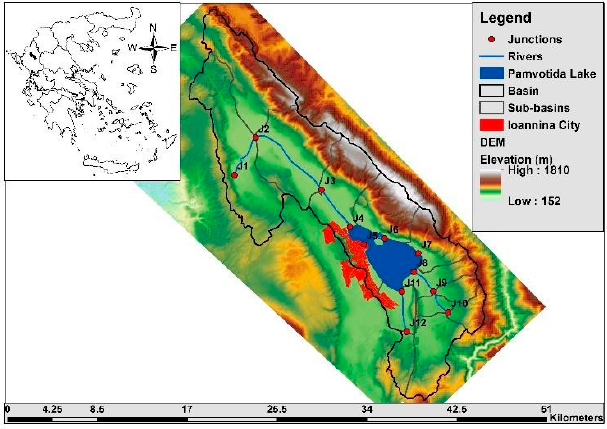
Figure 1. Map of Lake Pamvotida Basin and modeling components (sub-basins, reaches,